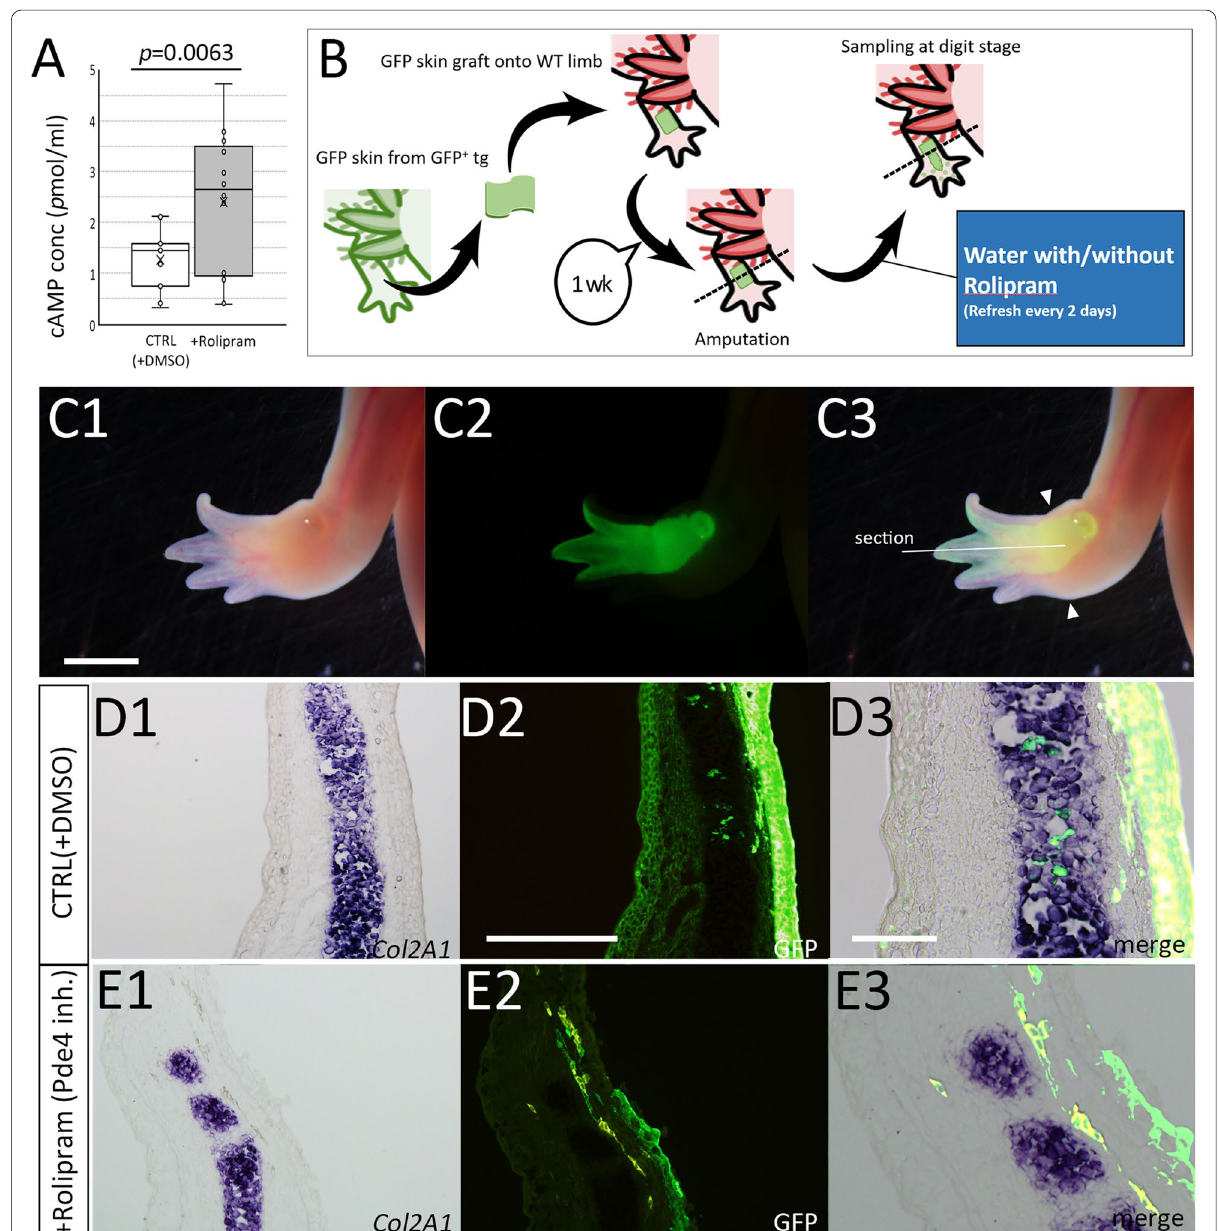
Fig. 6 Impaired transformation of dermal fibroblasts into cartilage cells by inhibition of Pde4b function by Rolipram. A Cyclic AMP concentration in limb tissues was measured by ELISA. B The schematic diagram of the experiment. C Rolipram treated limb in the bright-field view (C1), the dark field view (C2), and the merged image (C3). Scale bar in C1 3 mm. D , E Distribution of the GFP + cells in the regenerated limbs in the control = ( D ) and the Rolipram treated animal ( E ). Col2a1 expression was visualized I by in situ hybridization (D1, E1) and GFP signals were detected by immunofluorescence (D2, E2) on the identical sections. D3 and E3 were the highly magnified and merged images. The scale bar in D2 and D3 are 300 μm and 100 μm,